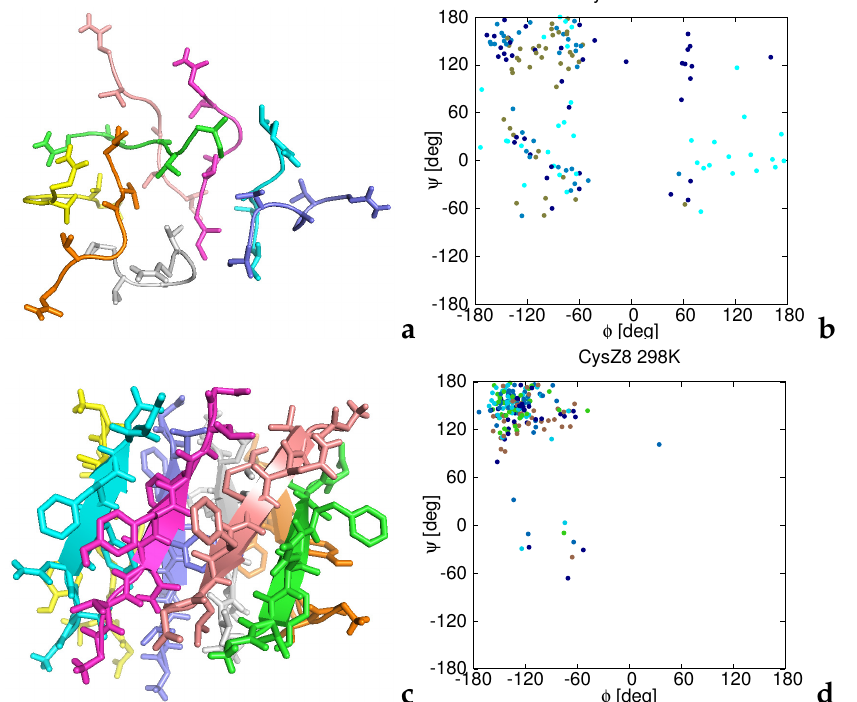
Figure 5. Representative structures of the octamers of CysZ5 ( a ) and CysZ8 ( c ) at T = 298 K obtained in MREMD simulations of eight-chain systems and the corresponding plots of the backbone φ and ψ angles collected from all five models obtained by the cluster analysis at this temperature ( b , d ). Each chain in panels a and c is colored by a different color. Backbones are represented as ribbons and the side chains are shown in the stick representation. The structures were obtained by converting the UNRES chains into the all-atom representation. Each point in the ( φ , ψ ) -plots is colored according to residue index (chain index ignored), from blue to red from the N- to the C-terminus. The drawings were produced with PyMol [64] and gnuplot [57],